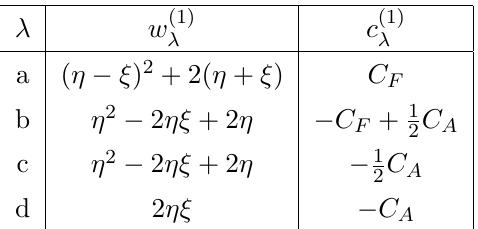
Table 1 . The weights w (1) and the color factors c (1) for the diagrams in (cid:12)gure 2. The weights for (cid:21) (cid:21) the symmetric diagrams are obtained by interchanging the (cid:17) and (cid:24) variables. The singular part of the infrared divergent diagram (a) is subtracted as discussed in the